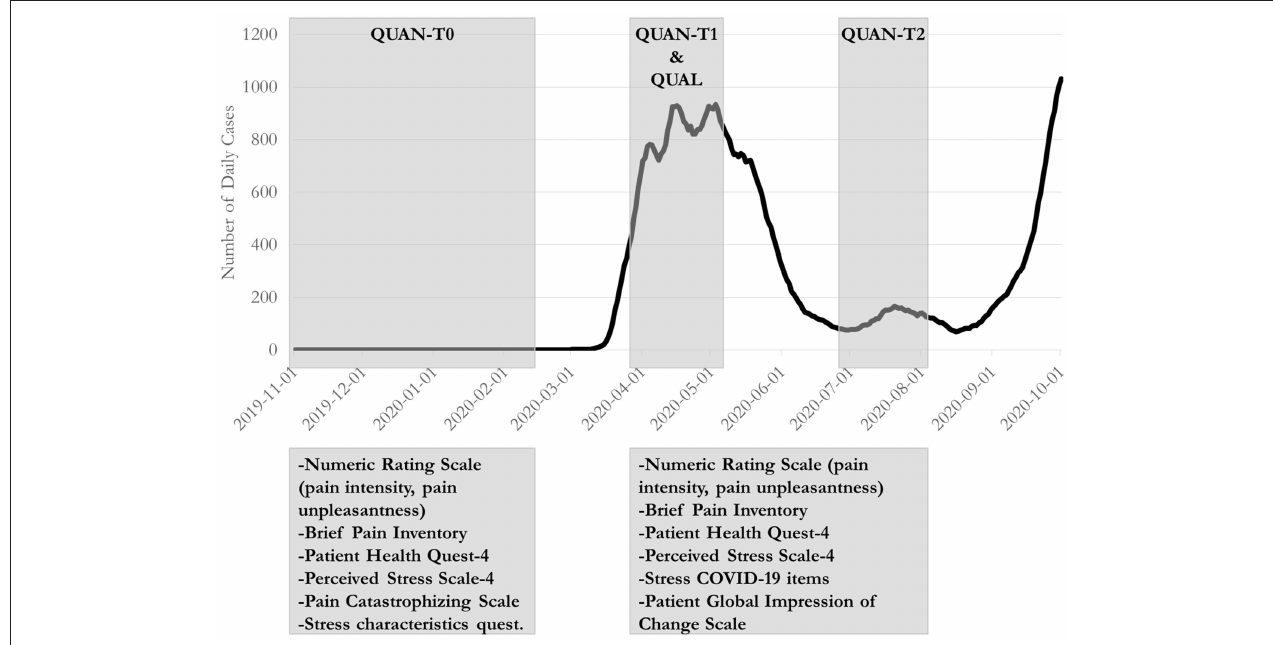
FIGURE 1 | Timing of baseline and follow-up measures in relation to the evolution of the COVID-19 pandemic in Quebec, Canada. The shaded gray zones refer to the periods during which participants completed the time point measures or interviews.